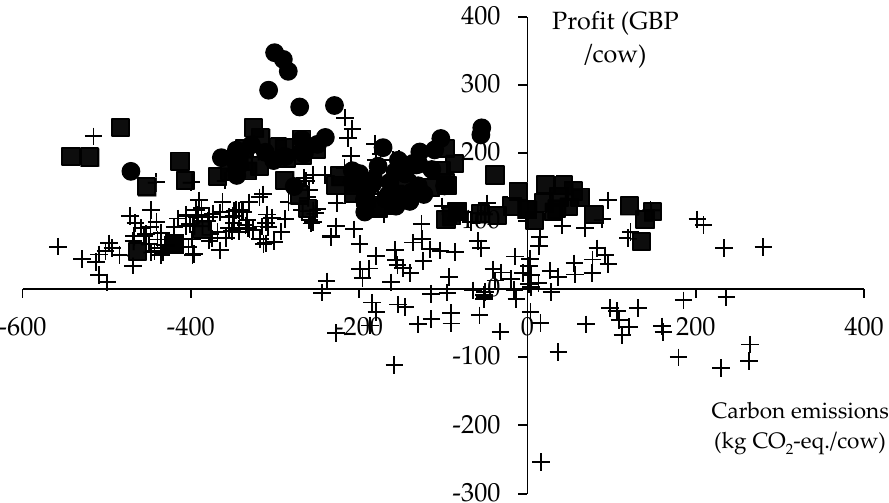
Figure 1. Profit (GBP/cow) and carbon (kg CO 2 -eq./cow) index values calculated for milking cows (+), first lactation heifers ( ■ ) and one-year-old heifers ( ● ) within the herd studied.